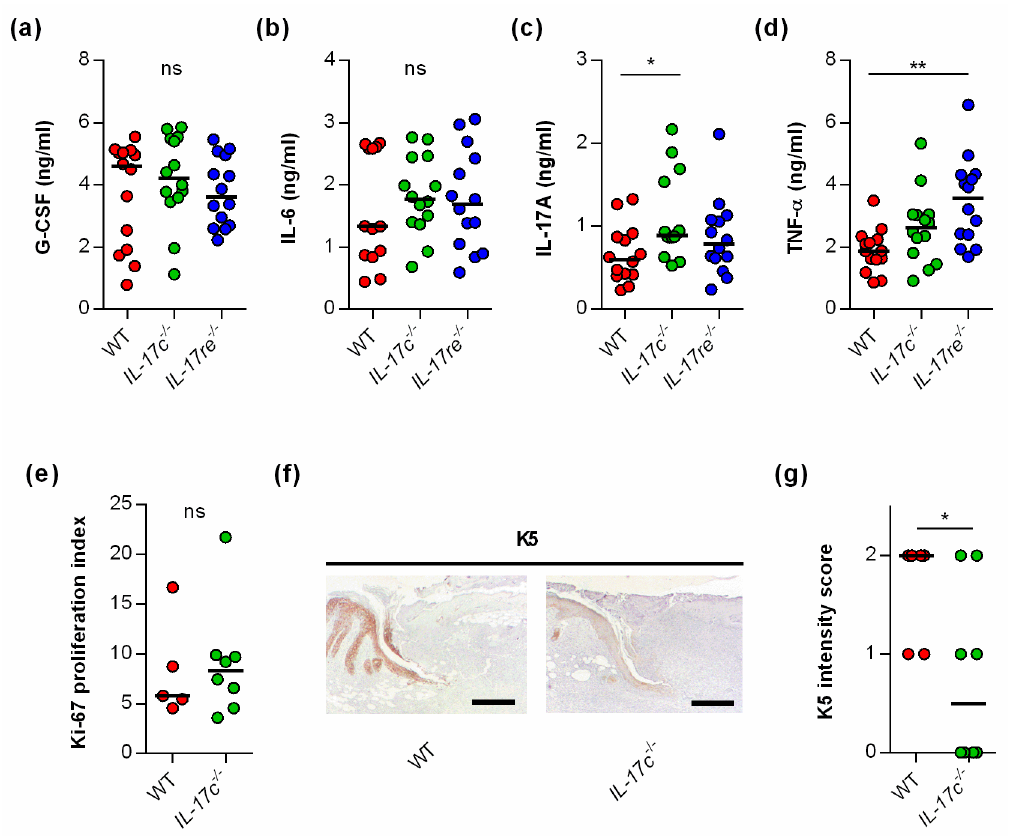
Figure 3. The deficiency for IL-17C and IL-17RE does only marginally affect the contents of wound-healing-associated cytokines in S. aureus -infected wounds. ( a – d ) Concentrations of G-CSF ( a ), IL-6 ( b ), IL-17A ( c ) , and TNF- α ( d ) in wound homogenates of 6 days old S. aureus -infected wounds ( n = 14 per group). ( e ) Ki-67 proliferation indices of tissue sections obtained from S. aureus -infected wounds of wild-type and IL-17c − / − mice at 6 days post-infection ( n = 5–7). ( f ) Representative images of K5-stained tissue sections obtained from S. aureus -infected wounds of WT and IL-17c − / − mice at 6 days post- infection. Scale bar, 1 mm. ( g ) Intensity scores of K5-positive cells in the epidermal regions of the infected wound edges ( n = 6 – 8 per group). Each symbol represents an individual wound. Horizontal bars indicate the median of all observations. Data were compared by one-way ANOVA and Holm –Sidak’s multiple comparison test ( a – d) or the unpaired Student’s t-test (e,g). ns, not significant; * p < 0.05; ** p < 0.01.